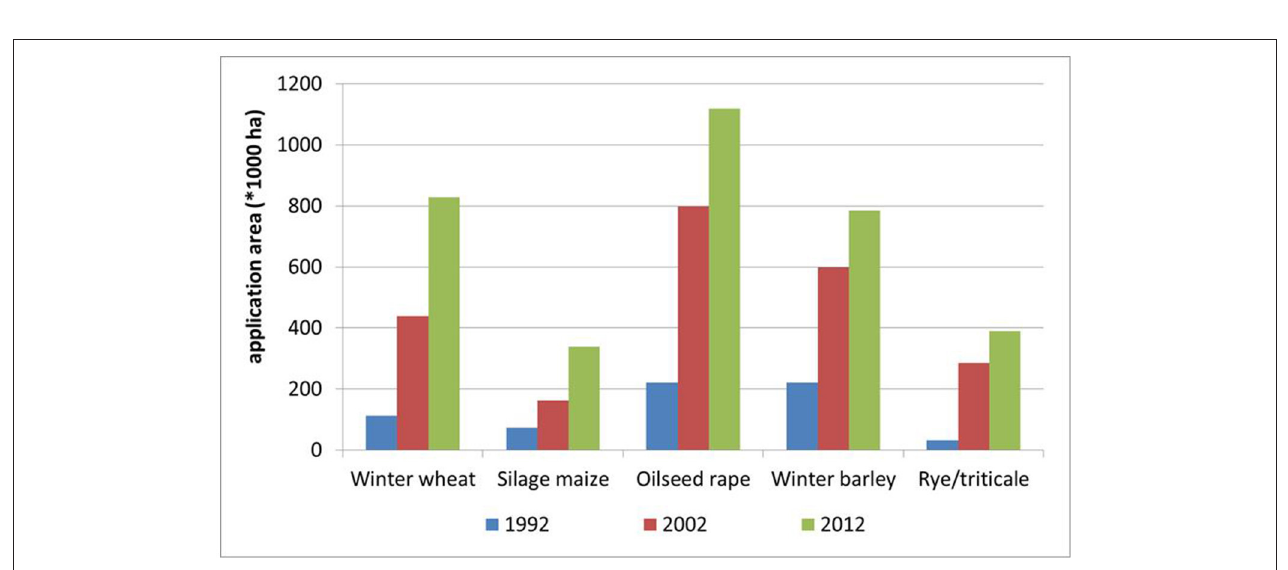
FIGURE 2 | Total GLY application area for each crop considered for amphibian coincidence during the three investigation periods over 20 years.